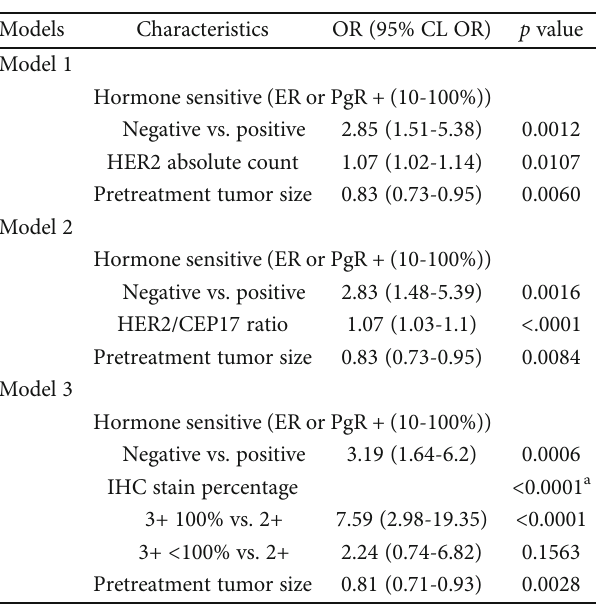
Table 5: Multivariate models predicting residual cancer burden following neoadjuvant chemotherapy for HER2+ breast